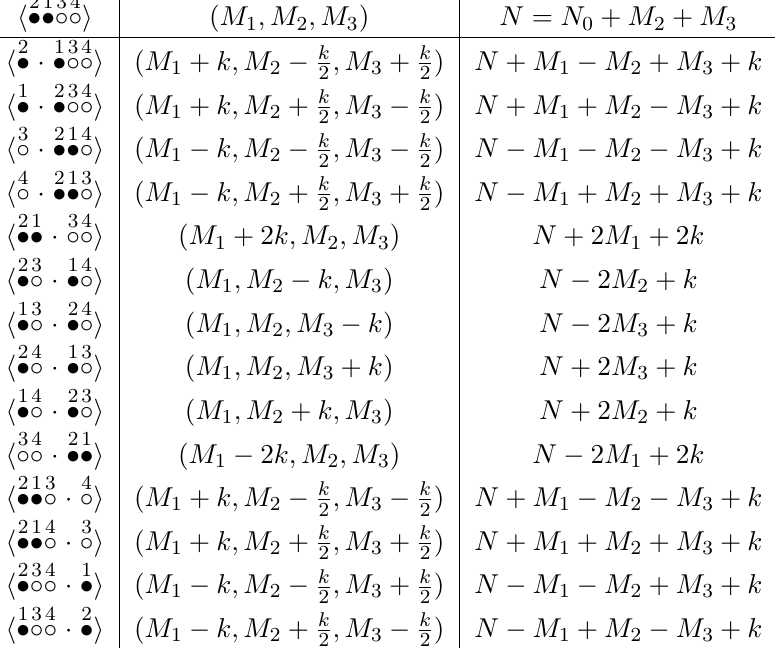
Table 4 . Changes of the relative ranks ( M 1 , M 2 , M 3 ) and the overall rank N = N 0 + M 2 + M 3 , for the brane configurations of the B in applying duality cascades. Note that, instead of the original notation of the overall rank N consider the reference rank N = N